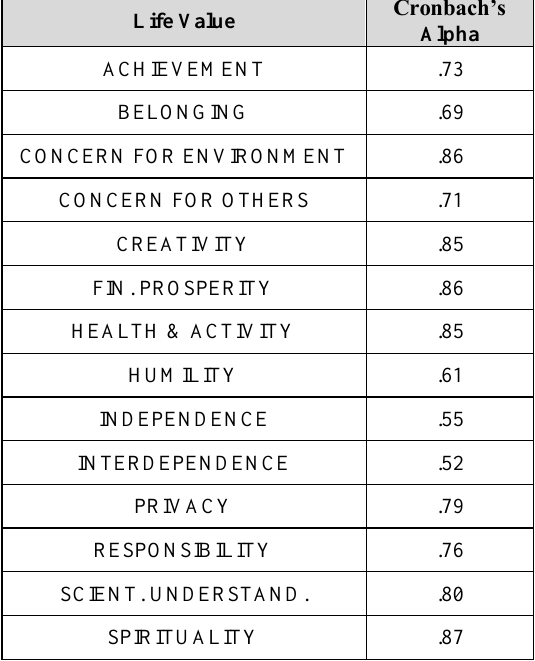
Table 1: Cronbach’s